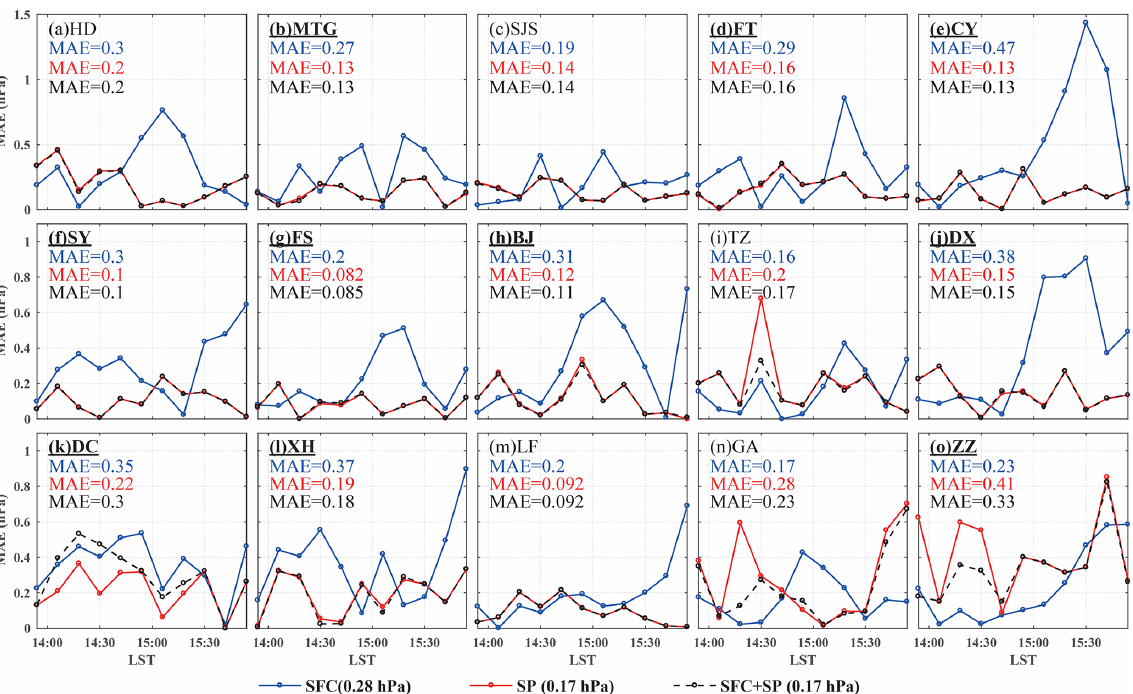
Figure 16. (a) – (o) Temporal distribution of mean absolute error (MAE) between model analyses and observations at different surface stations for the smartphone experiment (SP; red line), the station observation experiment (SFC; blue line) and the station observation plus smartphone experiment (SFC + SP; black dash line), respectively. The temporally averaged MAE is also shown within each plot, and the average MAEs over all stations for the three experiments are shown below the plots. The underlined and bold station names indicate that the MAE difference between SFC and SP at those stations is significant with the confidence level of 90%. The stations are as follows: HD: Haidian; MTG: Mentougou; SJS: Shijingshan; FT: Fengtai; CY: Chaoyang; SY: Shunyi; FS: Fangshan; BJ: Beijing; TZ: Tongzhou; DX: Daxing; DC: Dachang; XH: Xianghe; LF: Langfang; GA: Guan; ZZ: Zhuozhou.